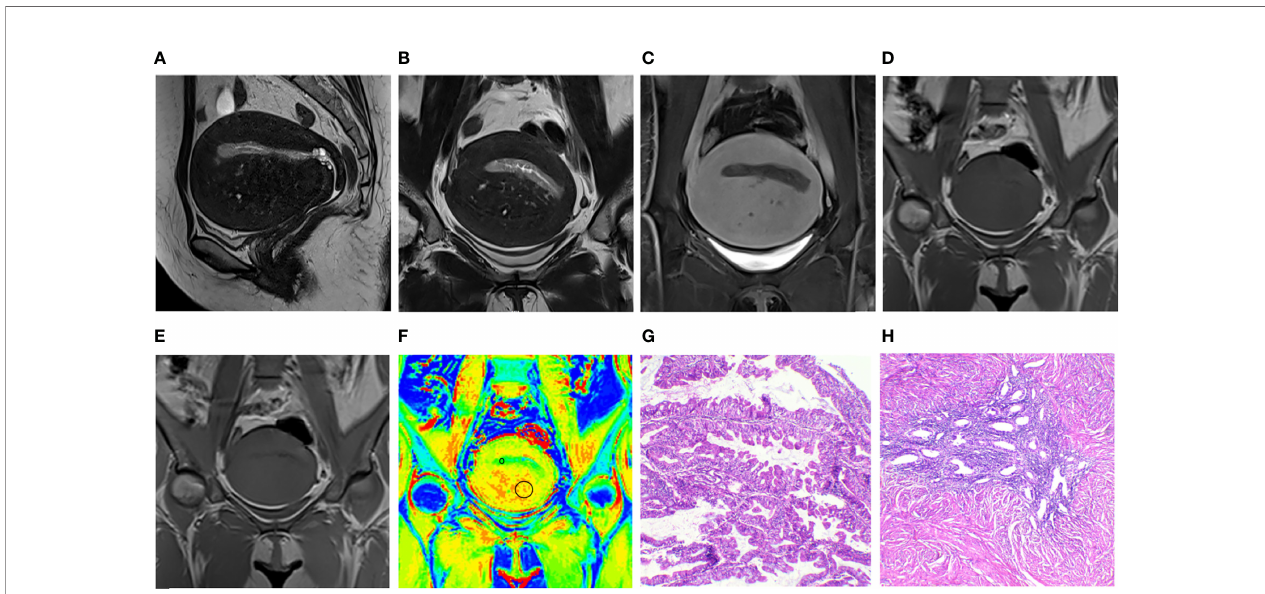
FIGURE 2 | Images and placements of the regions of interest in a 48-year-old patient with endometrial cancer and adenomyosis. (A – C) Sagittal and uterus-axial T2- weighted images (T2WI) and uterus-axial contrast-enhanced T1-weighted (T1WI) image. (D, E) Uterus-axial magnetization transfer (MT) imaging with and without MT pulse. (F) Pseudo-color magnetization transfer ratio (MTR) map; MTR values of endometrial cancer and adenomyosis are 8.07 and 12.31, respectively. (G, H) Hematoxylin and eosin staining map (40×) of endometrial cancer and